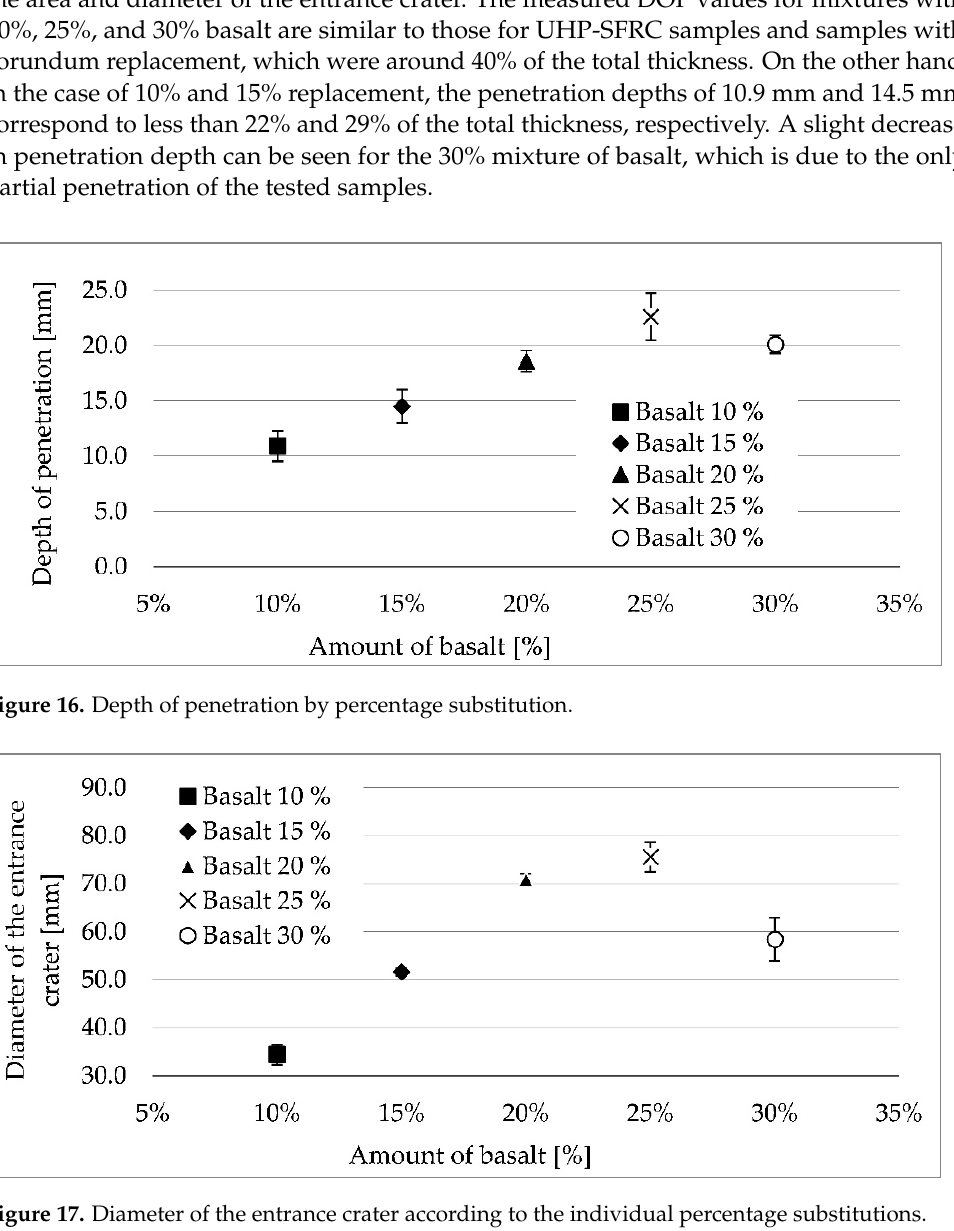
Figure 18. Size of the entrance crater area according to individual percentage substitutions. Figure 19. Size of the rear crater area according to individual percentage substitutions.